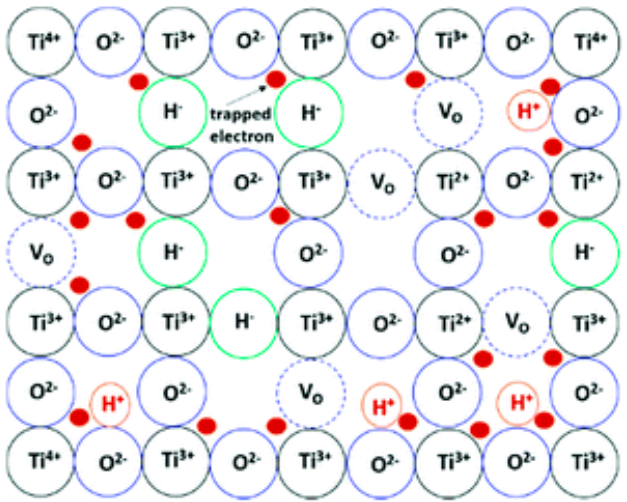
Figure 8. Schematic illustration of the main defects existing in reduced TiO 2 upon boron hydride reduction. (V O : Oxygen vacancy; H − : Hydride anion in lattice oxygen site; H + : Proton bonding